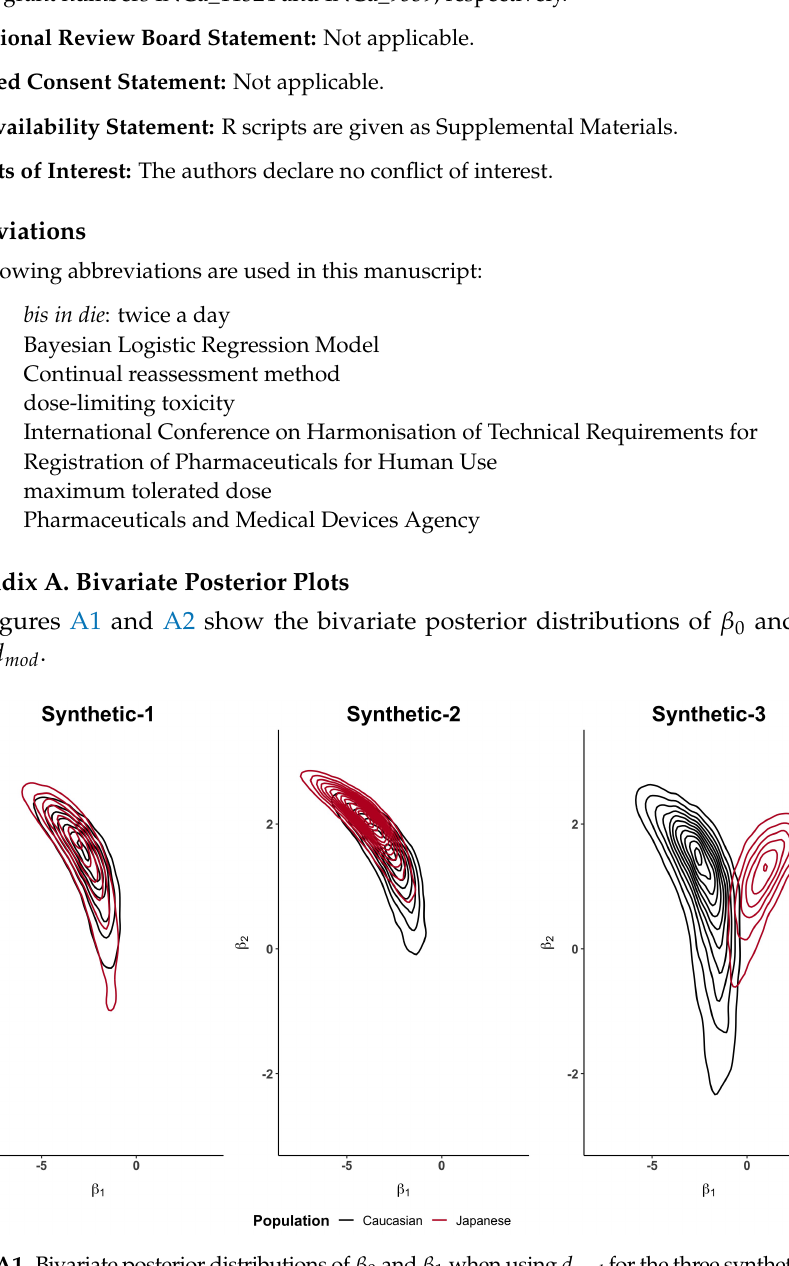
Figure A1. Bivariate posterior distributions of β 0 and β 1 when using d mod for the three synthetic